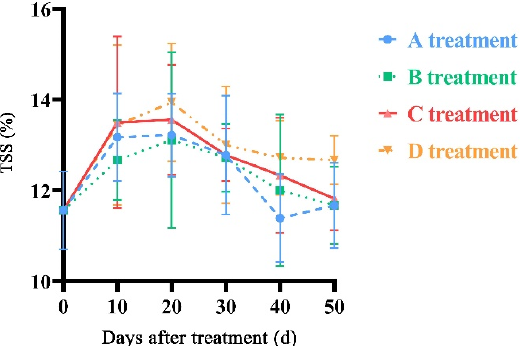
Figure 4. Changes in TSS of ‘Yonglian No.1’ peach fruits during storage in four treatments. Vertical bars represent the standard errors. The different lower case letters at each time point indicate significant difference at p < 0.05 using Duncan’s multiple range tests.